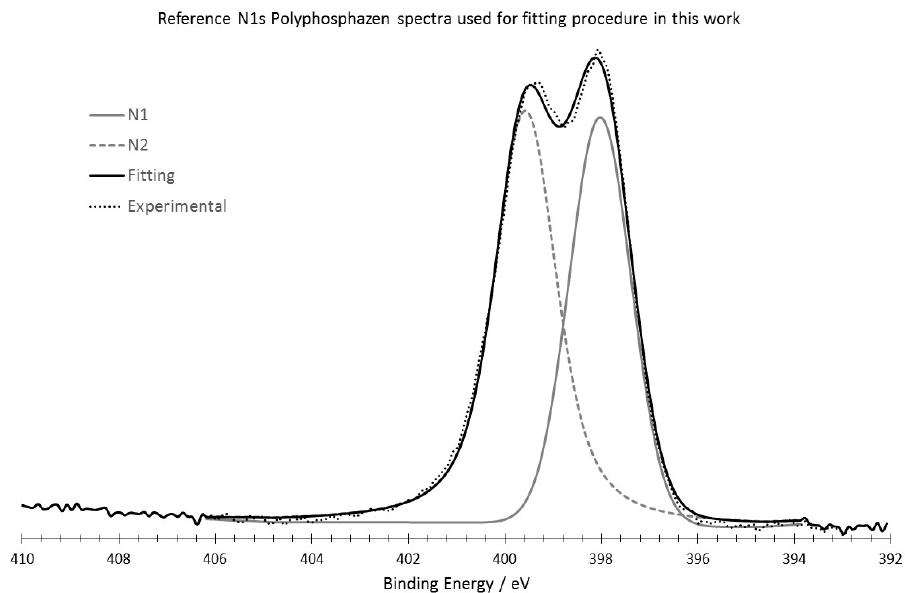
Figure A1. Reference polyphosphazen N1s XPS spectra and fitting.